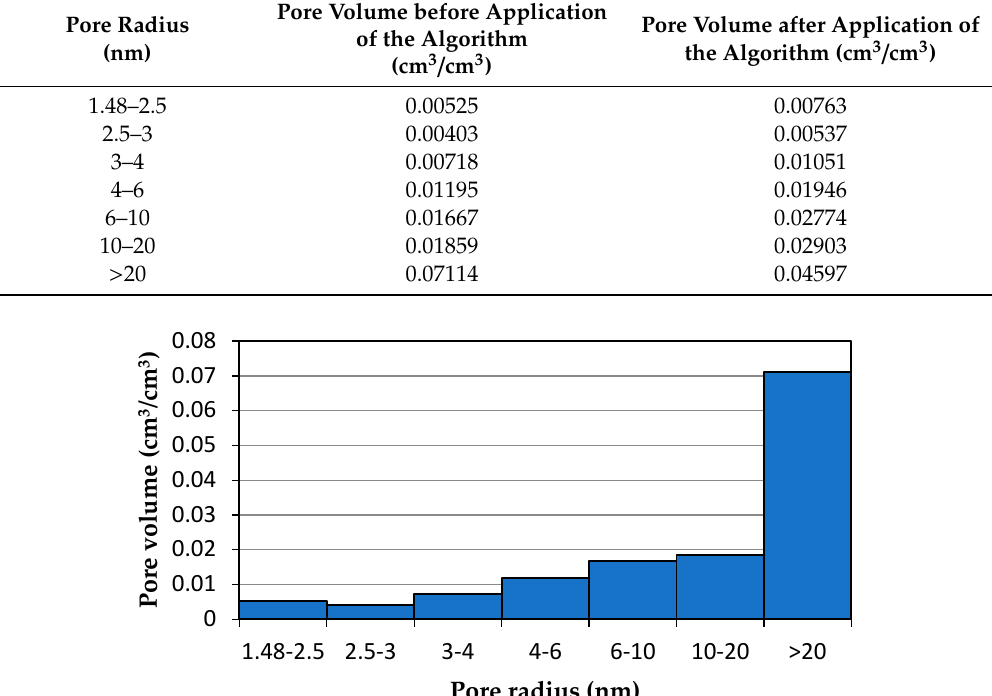
Figure 15. Pore size distribution that was obtained by thermoporometry from the phase transition energy distribution with the use of the modified algorithm.Running the proposed algorithm on the obtained phase transition energies was paramount to correctly determine the pore size distribution and, consequently, to predict the durability of materials. This knowledge provides an explanation of material properties, including the amount of capillary water in a unit of time, strength, and resistance to an aggressive environment. 7. Conclusions If the process of the reasoning underlying the calculation procedure with the algorithm that accounts for the thermal inertia of the measurement system is correct, the size of pores and their distribution in cement mortar can be described with much greater precision. In the case of the tested CEMII/B ‐ V mortar (w/c = 0.53), 38.6% of the total ice–water energy of phase transition E sum was recorded over the temperature range above 0 °C. This is obviously a result that diverges from physical knowledge. When the energy distribution was used without taking the proposed modified algorithm into account, the volume of the relatively largest pores was greatly overestimated, while that of the smaller pores (r p < 20 nm) was underestimated, in some cases by 70%. The proposed calculation formula can be used to analyze pore structure in other capillary and porous materials. Appendix A